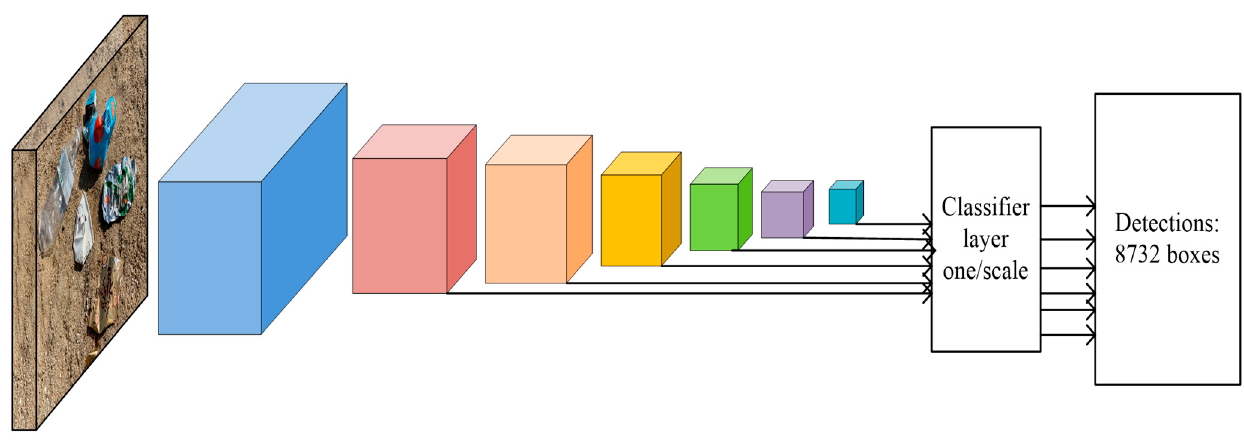
Figure 2. The basic structure of SSD .